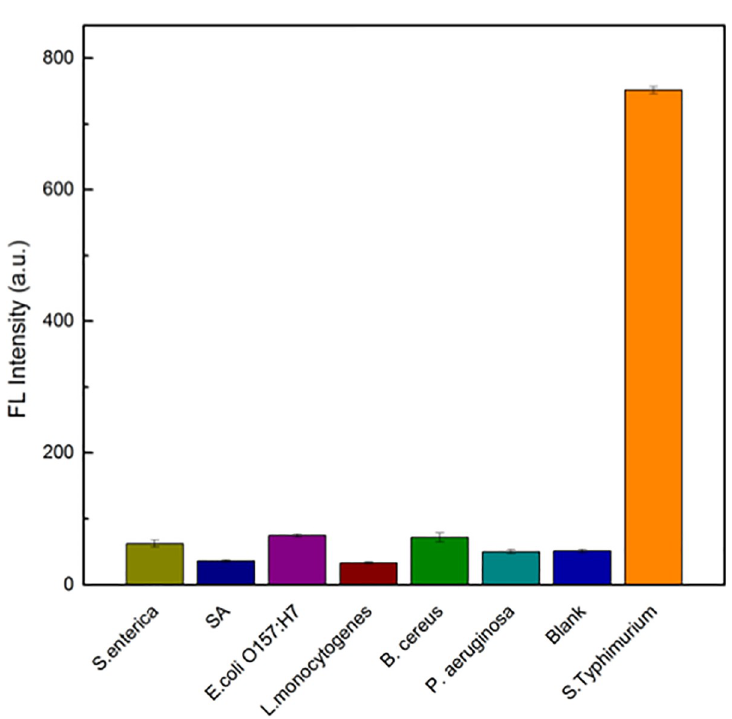
Fig 8. Specificity result for the detection of S . enteritidis , S . aureus , E . coli O157 : H7 , L . monocytogenes , B . cereus , P . aeruginosa and S . Typhimurium .